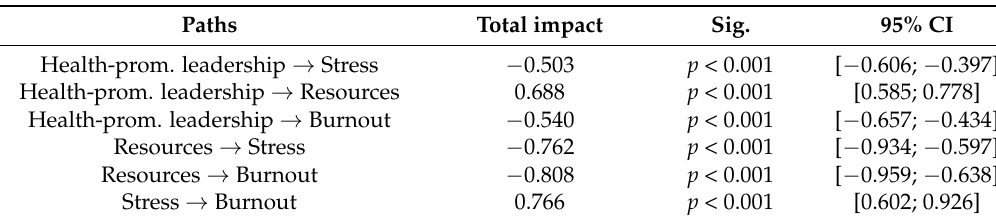
Table 4. Total impacts in the structural model—sample